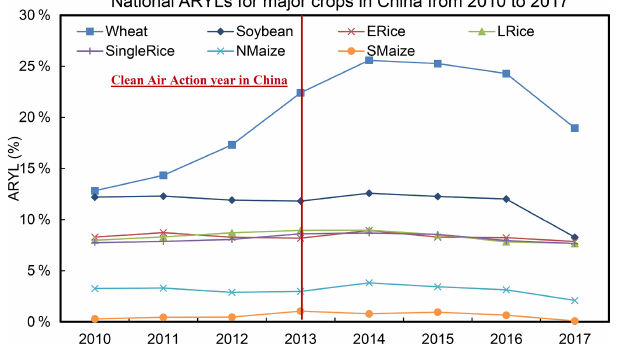
Figure 7. National average relative yield loss (ARYLs) from 2010 to 2017. The south maize (SMaize) and soybean are multiplied by 10 to be comparable with other